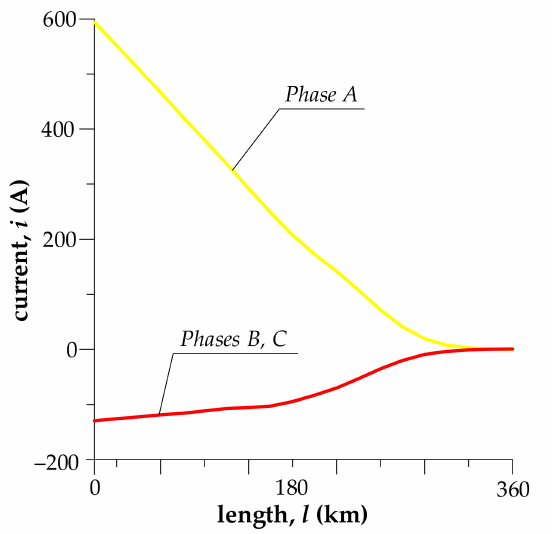
Figure 5. Space distribution of current changes at t = 0.001